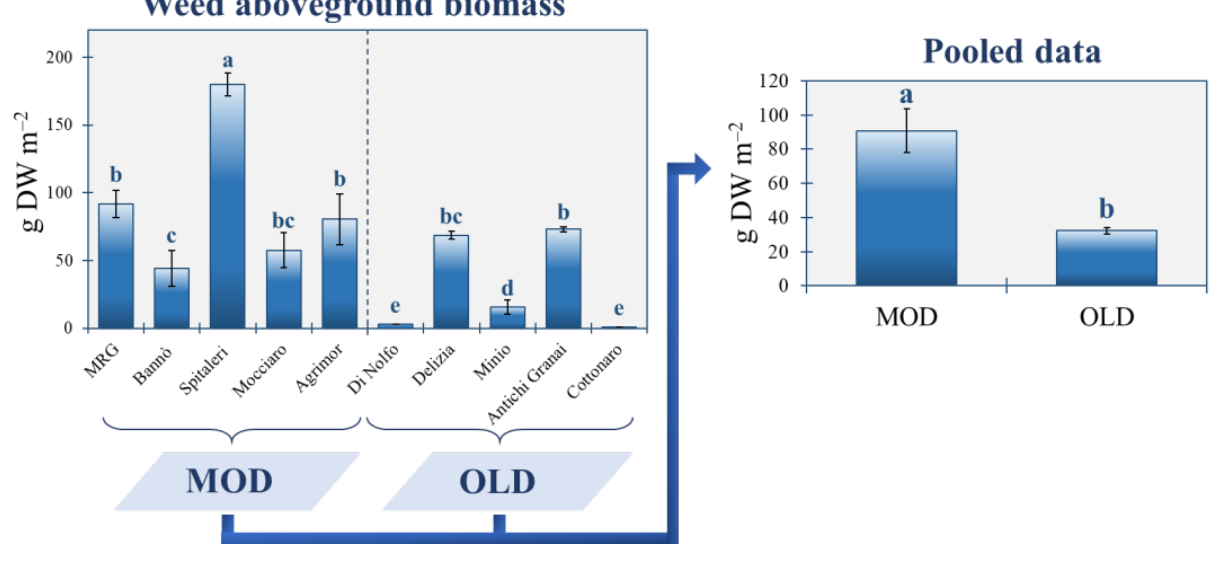
Figure 2. Aboveground biomass (g DW m − 2 ) of the real weed flora across the 10 farms under study. Bars are the standard deviation ( n = 3). Different letters indicate statistical significance by applying one-way analysis of variance with Tukey’s HSD test at p ≤ 0.05. MOD: wheat modern varieties group; OLD: wheat old landraces group.